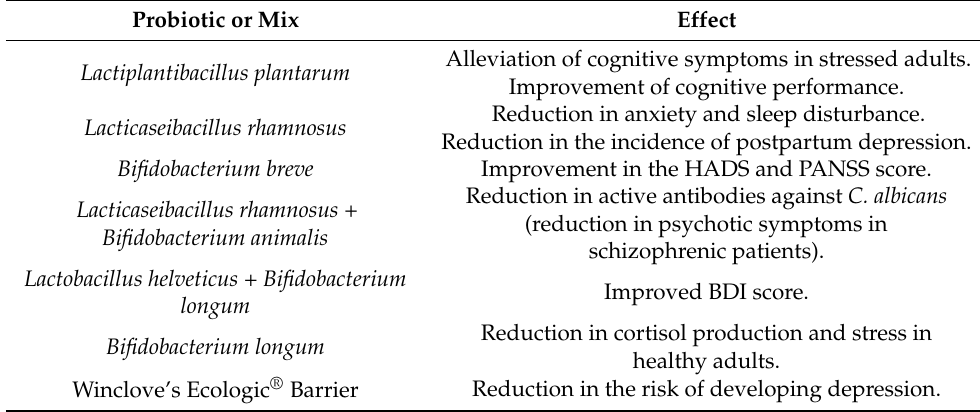
Table 3. Overview of possible psychobiotic effects of some species. Probiotic or Mix Effect Alleviation of cognitive symptoms in stressed adults. Lactiplantibacillus plantarum Improvement of cognitive performance. Reduction in anxiety and sleep disturbance. Lacticaseibacillus rhamnosus Reduction in the incidence of postpartum depression. Bifidobacterium breve Improvement in the HADS and PANSS score. Reduction in active antibodies against C. albicans Lacticaseibacillus rhamnosus + (reduction in psychotic symptoms in Bifidobacterium animalis schizophrenic patients). Lactobacillus helveticus + Bifidobacterium Improved BDI score. longum Reduction in cortisol production and stress in Bifidobacterium longum healthy adults. Winclove’s Ecologic ® Barrier Reduction in the risk of developing